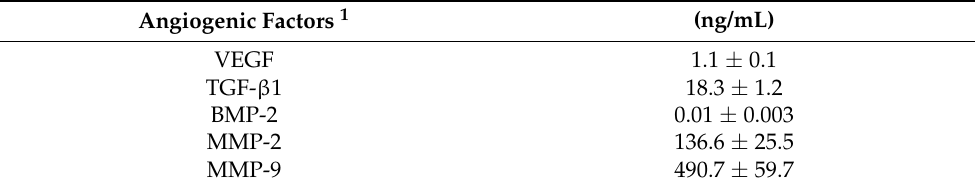
Table 2. Angiogenic factors released by